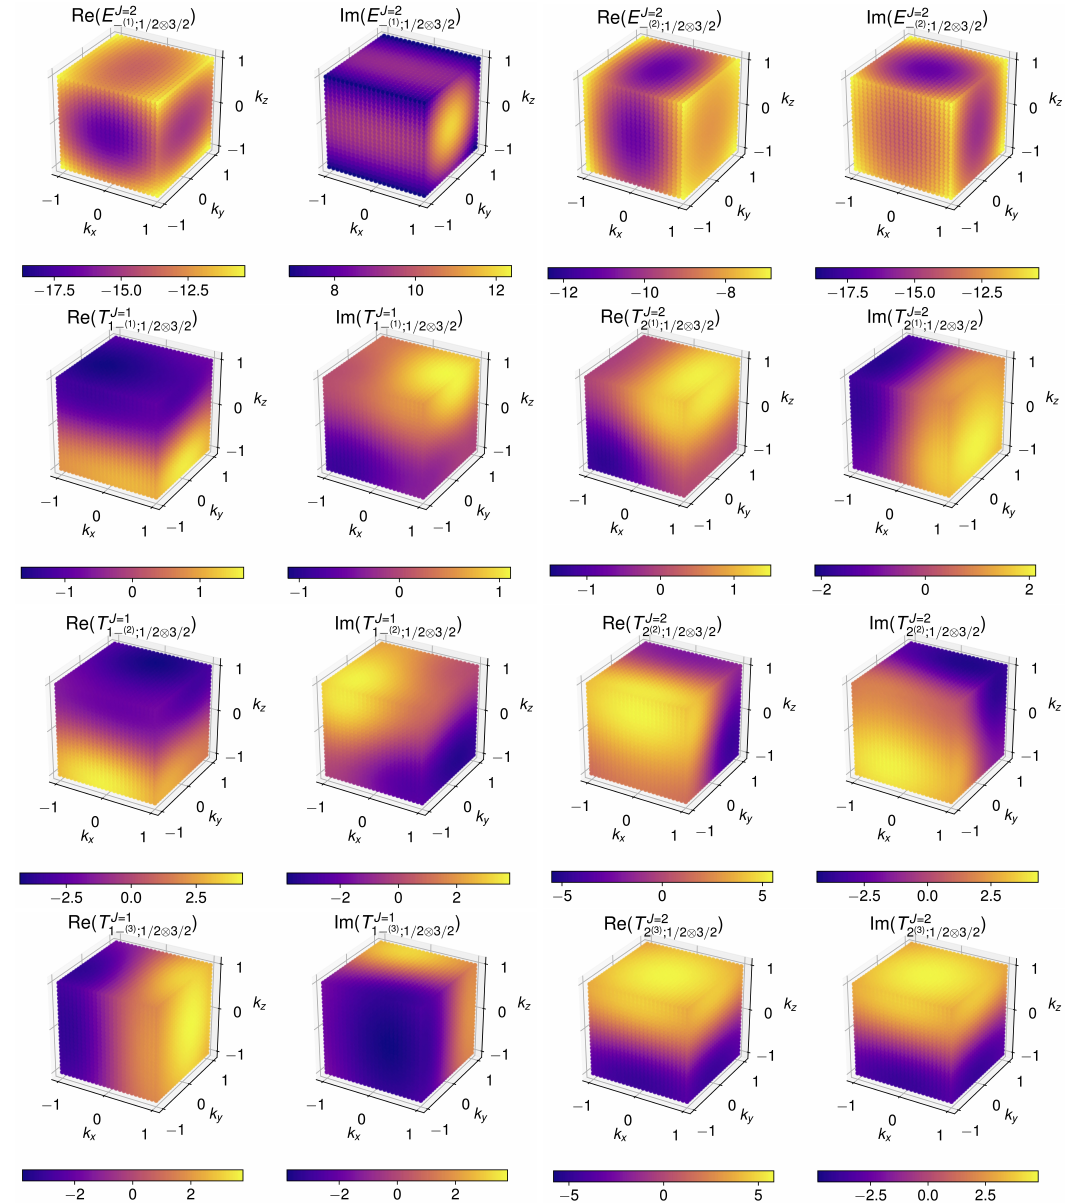
Figure 10: Momentum space distribution of the superconducting states arising from the novel Kondo interaction presented in Table 2 and Fig.